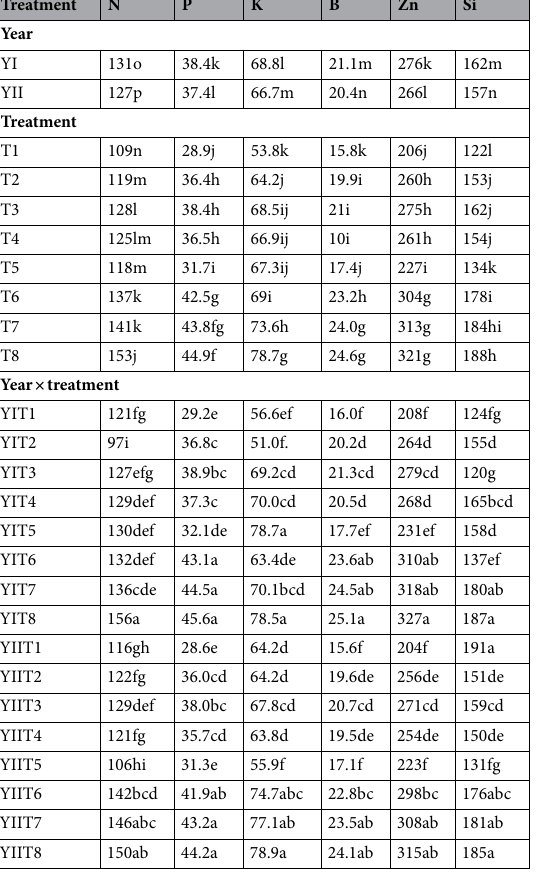
Table 3. Effect of seed priming on total plant uptake (kg ha -1 ) of primary nutrients and micronutrients by direct-seeded rice in a field experimentduring 2019 (YI) and 2020 (YII). Means followed by different letters (Tukey ranking) differ significantly at 5% level of significance. Treatments detail in Table